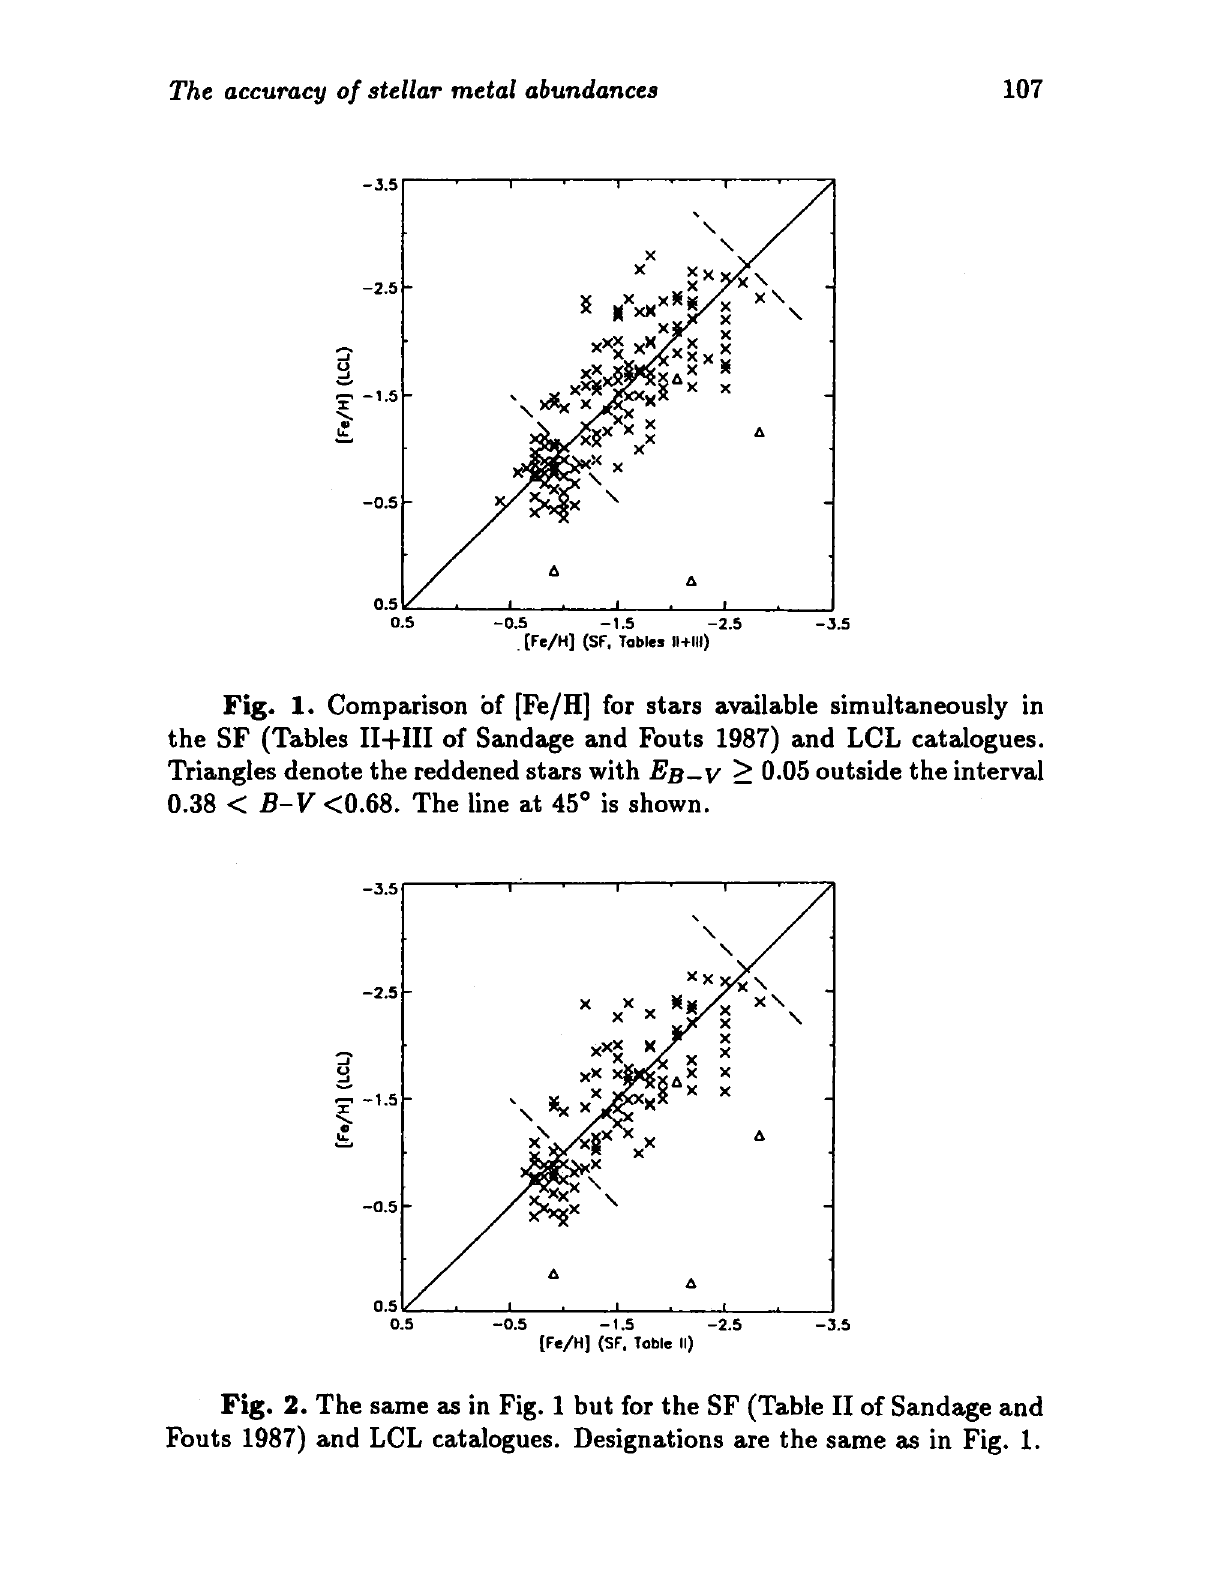
Fig. 2. The same as in Fig. 1 but for the SF (Table II of Sandage and Fouts 1987) and LCL catalogues. Designations are the same as in Fig.